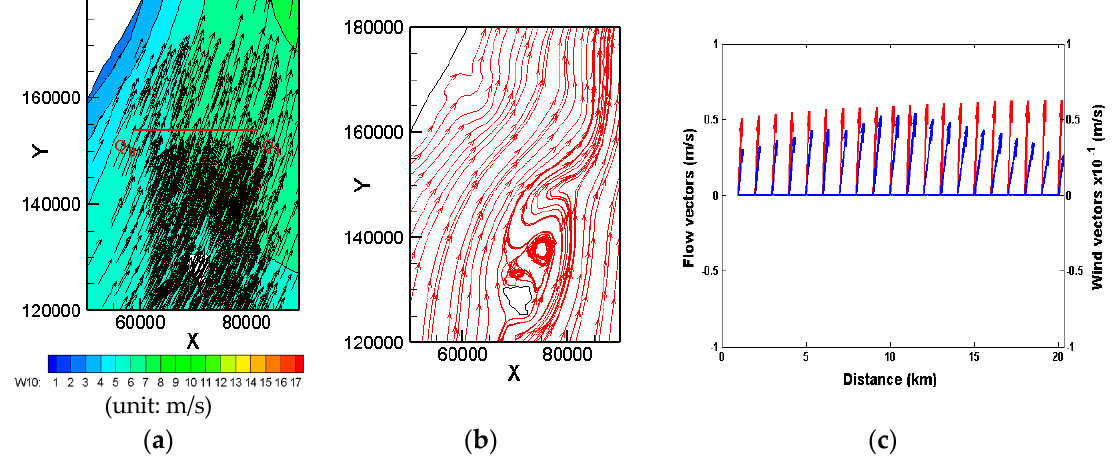
Figure 6. ( a ) W 10 vectors and contours (unit: m/s), ( b ) flow streamlines, and ( c ) wind vectors (red) and flow vectors (blue) of cross section Q 0 Q 1 at S 0 – S 4 five time instances of the typhoon Soulik, see Figure 5.